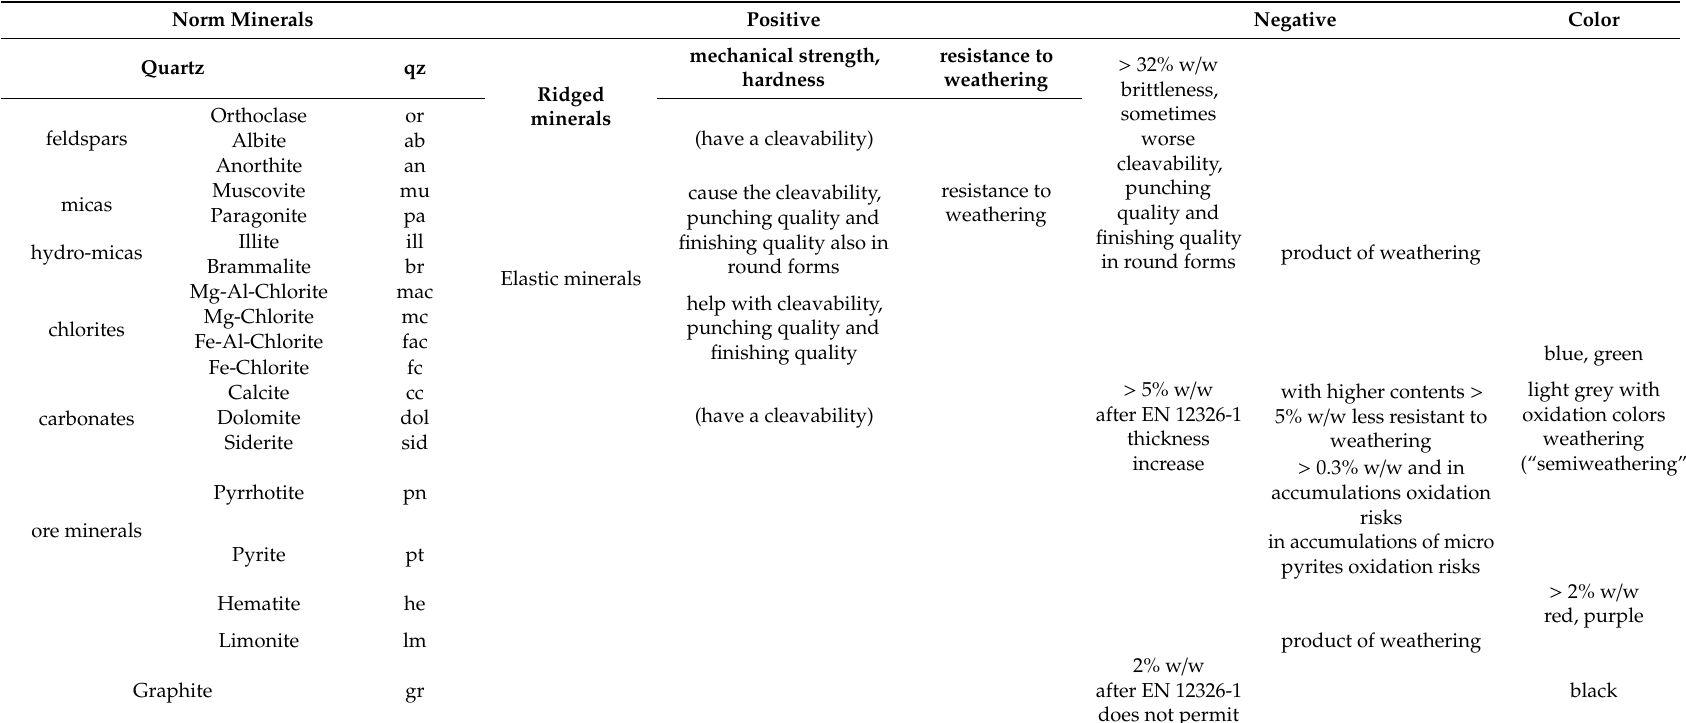
Table 2. Minerals and their influence on practical roofing slate